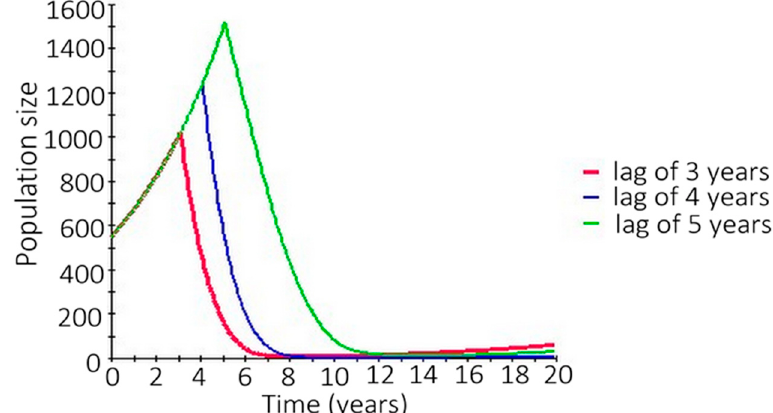
Figure 15. Effects of reducing carrying capacity while lengthening the lag period to 3, 4, and 5 years due to delayed maturity. The population fails within 7–12 years. The population collapse reported here resembles actual observed declines of rubber bush populations during periods of droughts